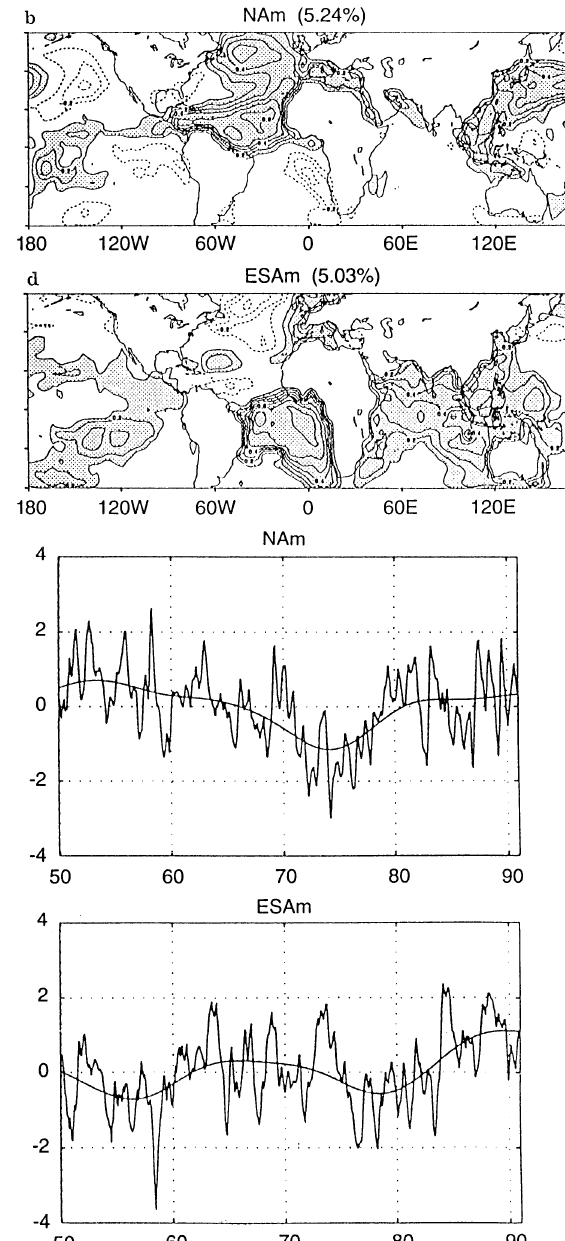
Fig. 2a (cid:177) d. Loading patterns and time-series of the first four SSTA modes obtained from a Varimax Rotated Principal Component Analysis performed on the period January 1950 to December 1990. Grey ( white ) areas and solid ( dashed ) lines display positive (negative)